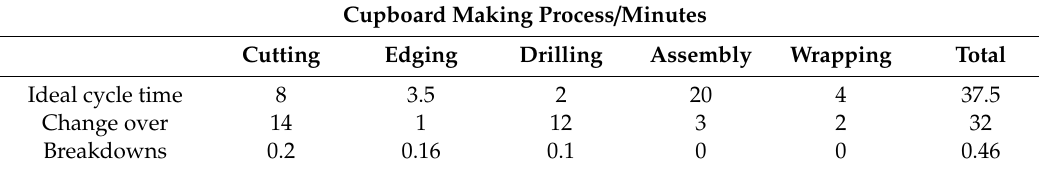
Table 3. OEE inputs.